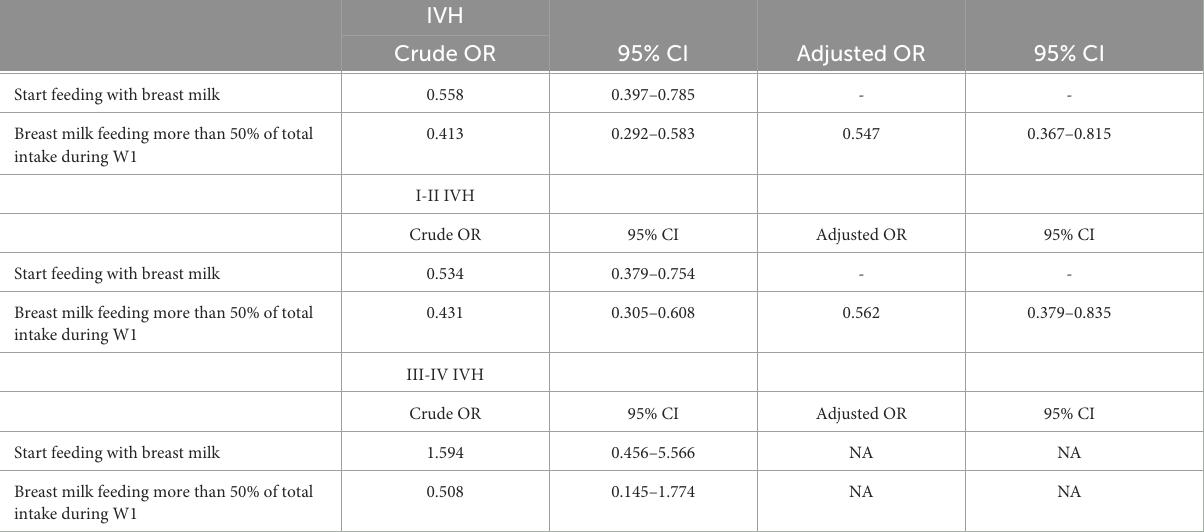
Start feeding with breast milk Breast milk feeding more than 50% of total intake during W1